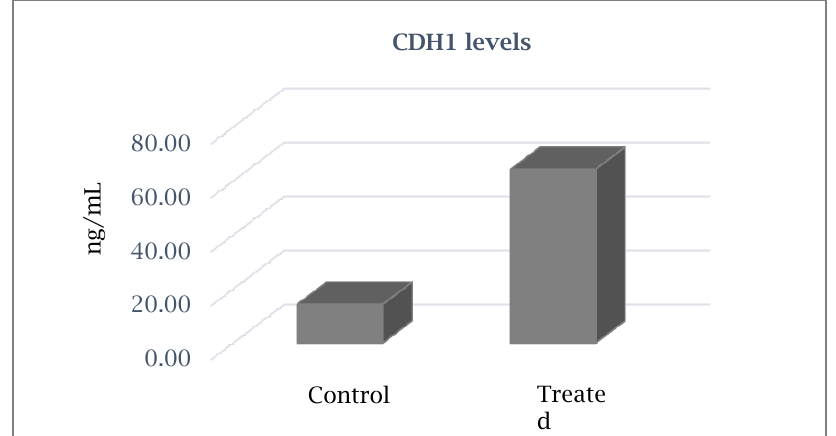
Figure 1. Increased E-cadherin level in fibroblasts after cyclosporine treatment vs. untreated cells (control). Table 1. Gene expression profile of 57 genes belonging to the “Extracellular Matrix and Adhesion Molecules” pathway analyzed using real-time PCR. Bold changes represent the expression levels of genes after 24 h treatment with cyclosporine A, as compared with untreated